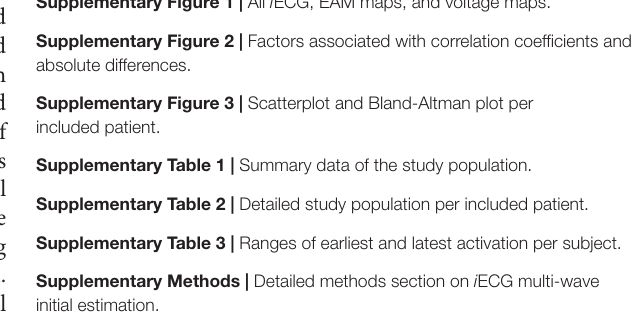
Supplementary Figure 1 | All i ECG, EAM maps, and voltage maps. Supplementary Figure 2 | Factors associated with correlation coefficients and absolute differences. Supplementary Figure 3 | Scatterplot and Bland-Altman plot per included patient. Supplementary Table 1 | Summary data of the study population. Supplementary Table 2 | Detailed study population per included patient. Supplementary Table 3 | Ranges of earliest and latest activation per subject. Supplementary Methods | Detailed methods section on i ECG multi-wave initial